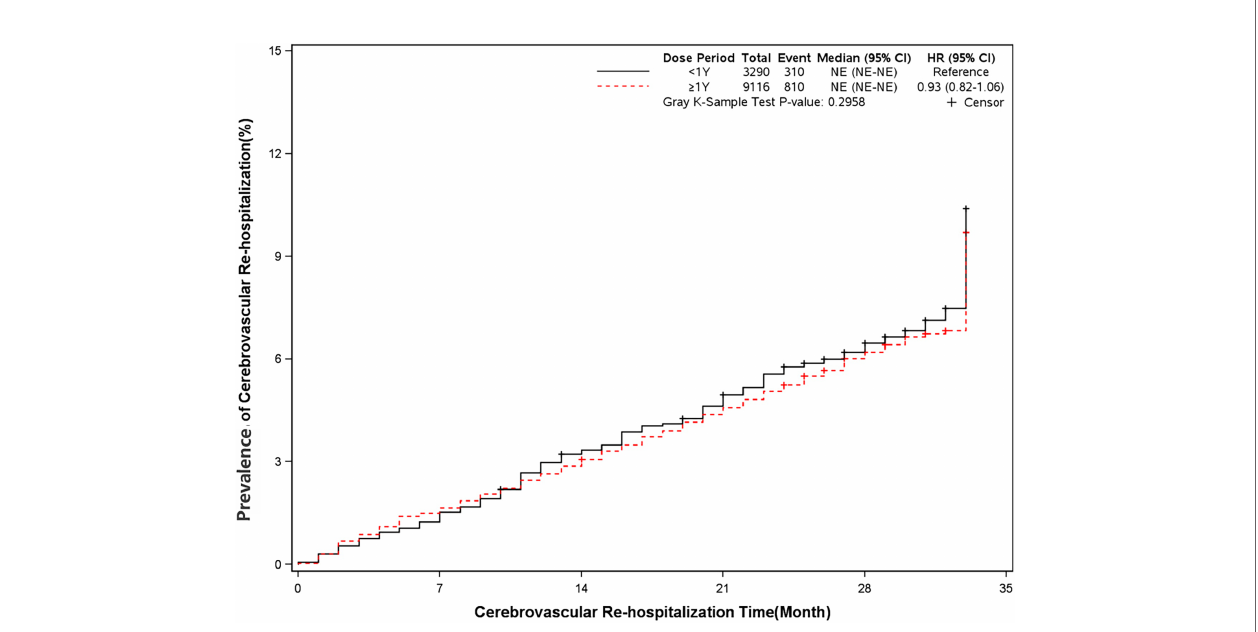
FIGURE 6 | Prevalence of cerebrovascular rehospitalization in two groups. Blackline: patients took clopidogrel continuously < 1 year; Red line: patients took clopidogrel continuously ≥ 1